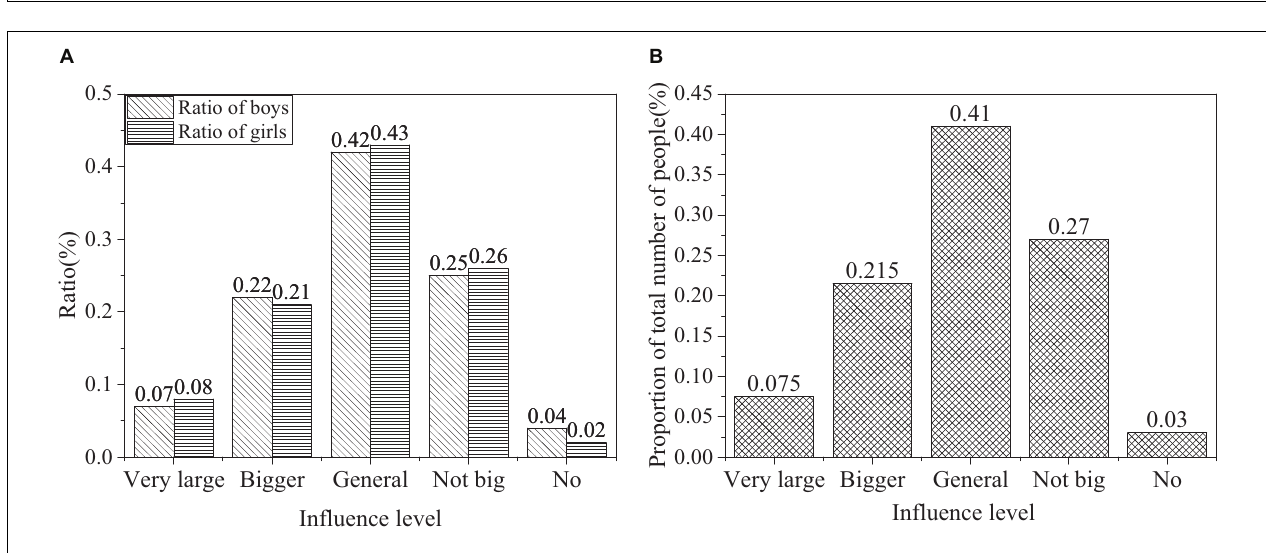
FIGURE 7 | Influence of network information on attitude of college students toward life [ (A) the ratio of male and female influence; (B) the ratio of all].